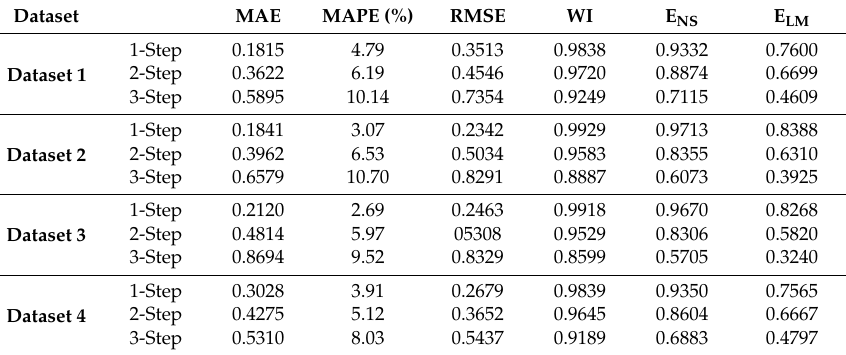
Table 6. Results of multi-step forecasting of the proposed